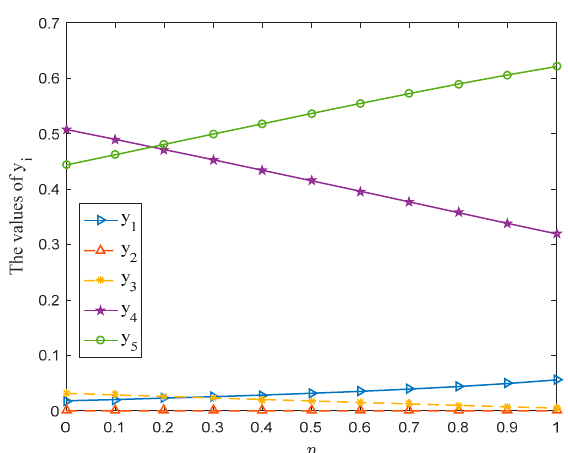
Figure 11. y i with parameter η varying from 0 to y with parameter η varying from 0 to 1. Figure 11. i